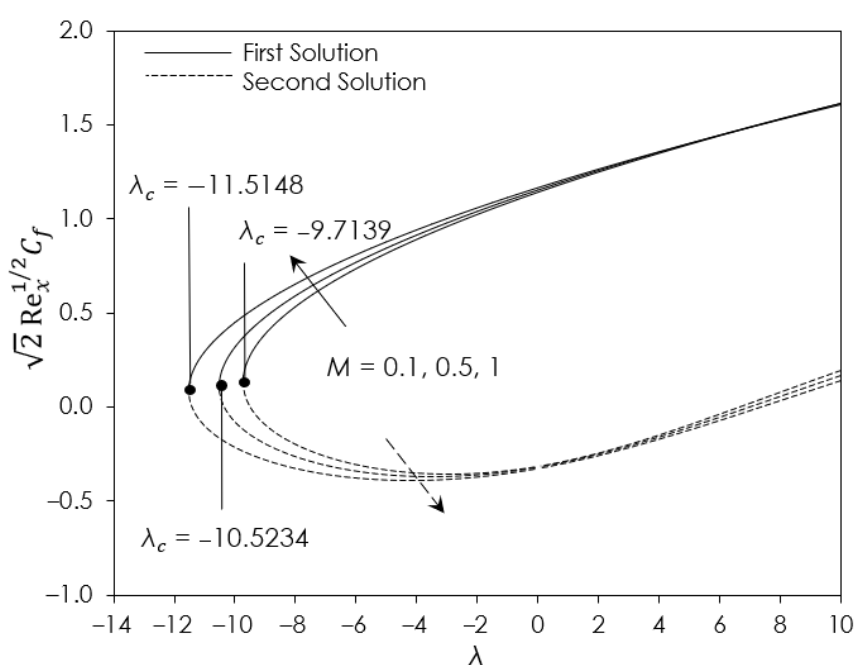
√ 2 Re 1/2 x C f for different values of M